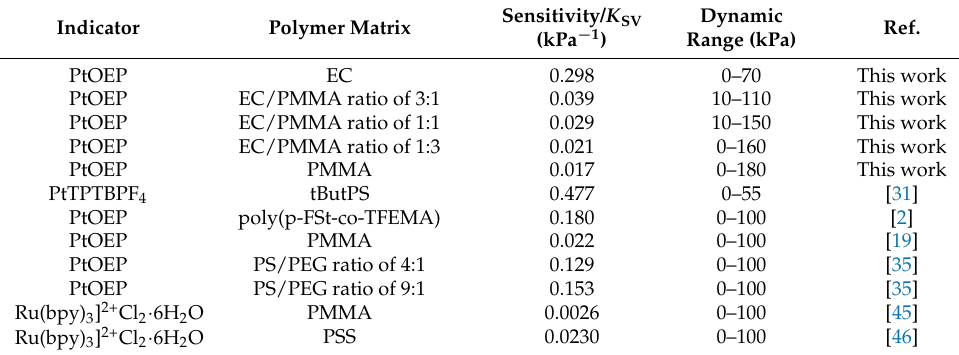
Table 3. Comparison of performance characteristics of the current sensing film with existing sens- ing